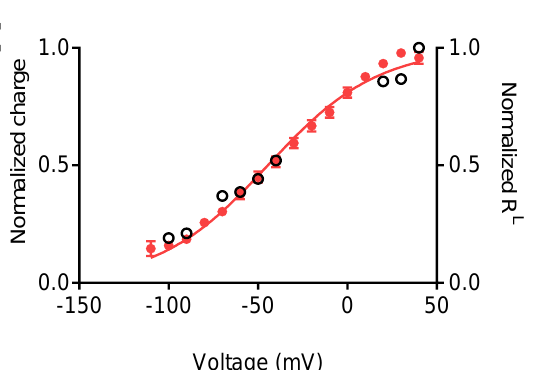
Figure 1. Voltage dependence of the M2R. ( A ) Dose–response curves obtained at − 60 mV and +40 mV show a rightward shift under depolarization; taken with permission from [22]. ( B ) Charge movement- associated currents measured from M2R-expressing oocytes; taken from [37]. ( C ) Current-voltage (red) and R L -voltage (empty circles) curves (receptors reside in low affinity state) showing a tight correlation between charge movement and shift in affinity; taken from